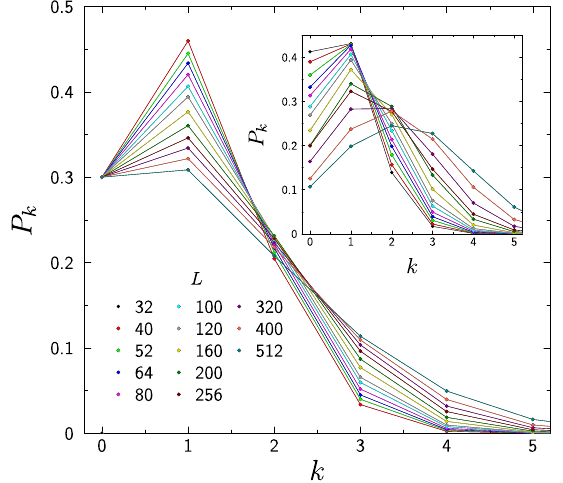
FIG. 13. Probability P 2 k , for a range of L . In the main panel, J is tuned so that P for each L . In the inset, J is fixed, J ¼ 0 . 08850 .